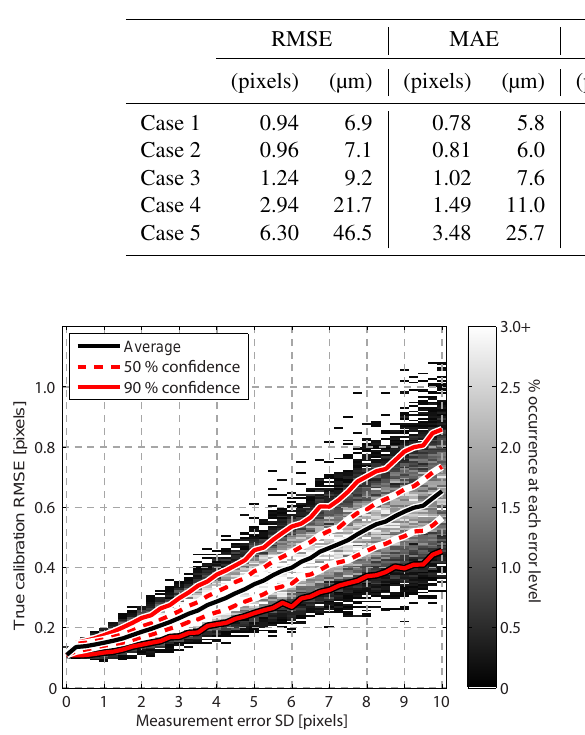
Table 3. Calibration error metrics for each case: root mean square error (RMSE); mean absolute error (MAE); standard deviation (SD); and measurement root mean square difference (RMSD m ) and measurement standard deviation (SD m ).